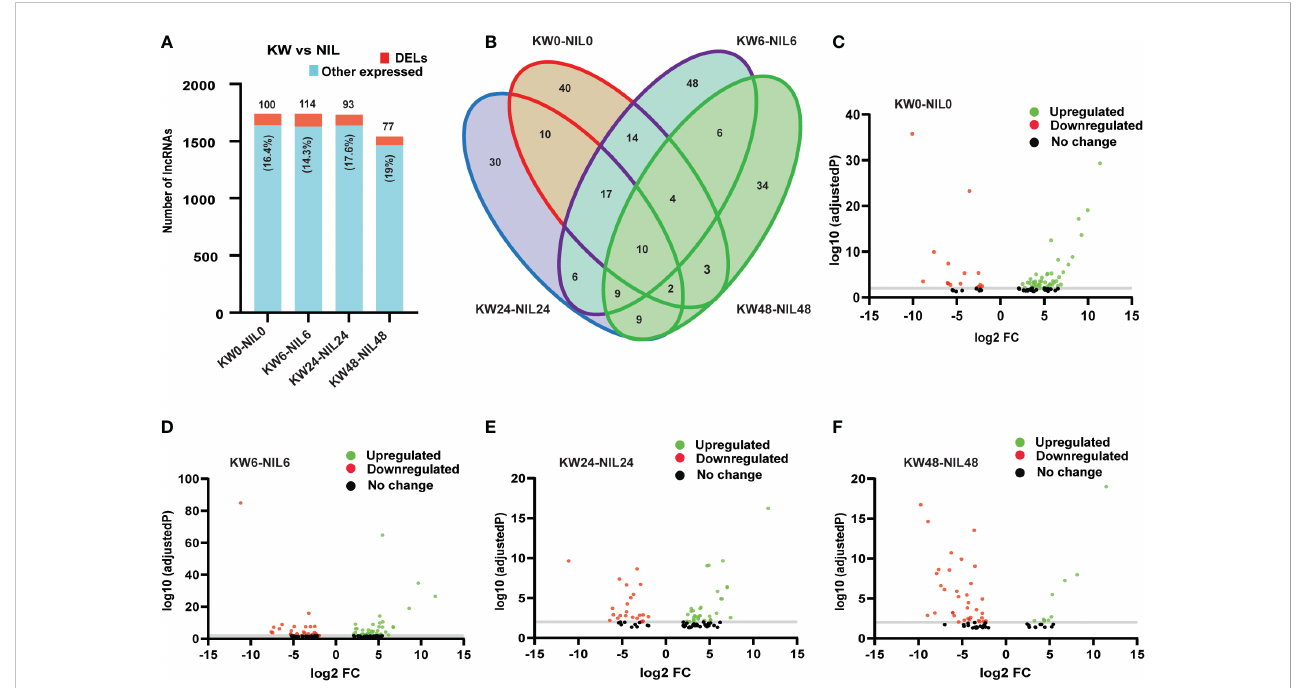
FIGURE 5 Comparison of differentially expressed long non-coding RNAs (DELs) among Kangwenqingzhan (KW) and its NIL under 0h, 6h, 24h, and 48h treatments. (A) Proportionate percentages of DELs to other expressed lncRNAs between the treatments of KW and NIL. Red color in the bar graph shows the proportion of DELs to other expressed lncRNAs illustrated in blue color. (B) Venn diagram depicts unique and overlapped DELs among different treatments of KW and NIL. (C – F) Volcano plots representing up and downregulated DELs for different treatments of KW and NIL at 0h, 6h, 24h, and